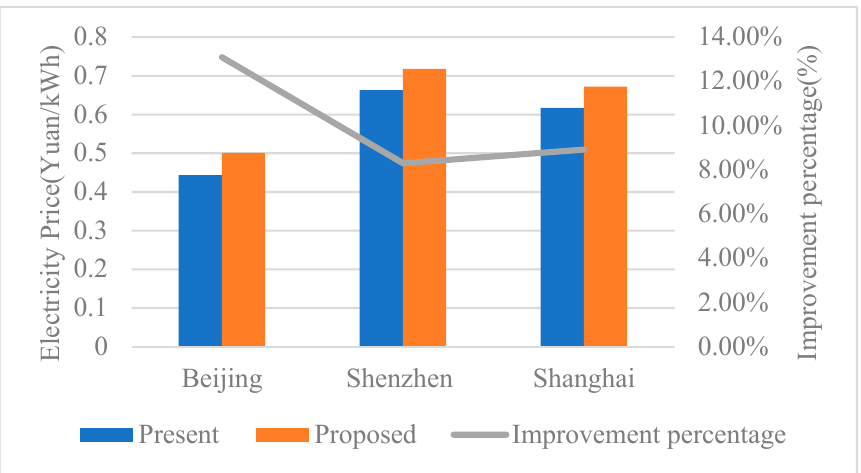
Figure 18. Electricity price adjustment scheme in various regions in the office building scenario.